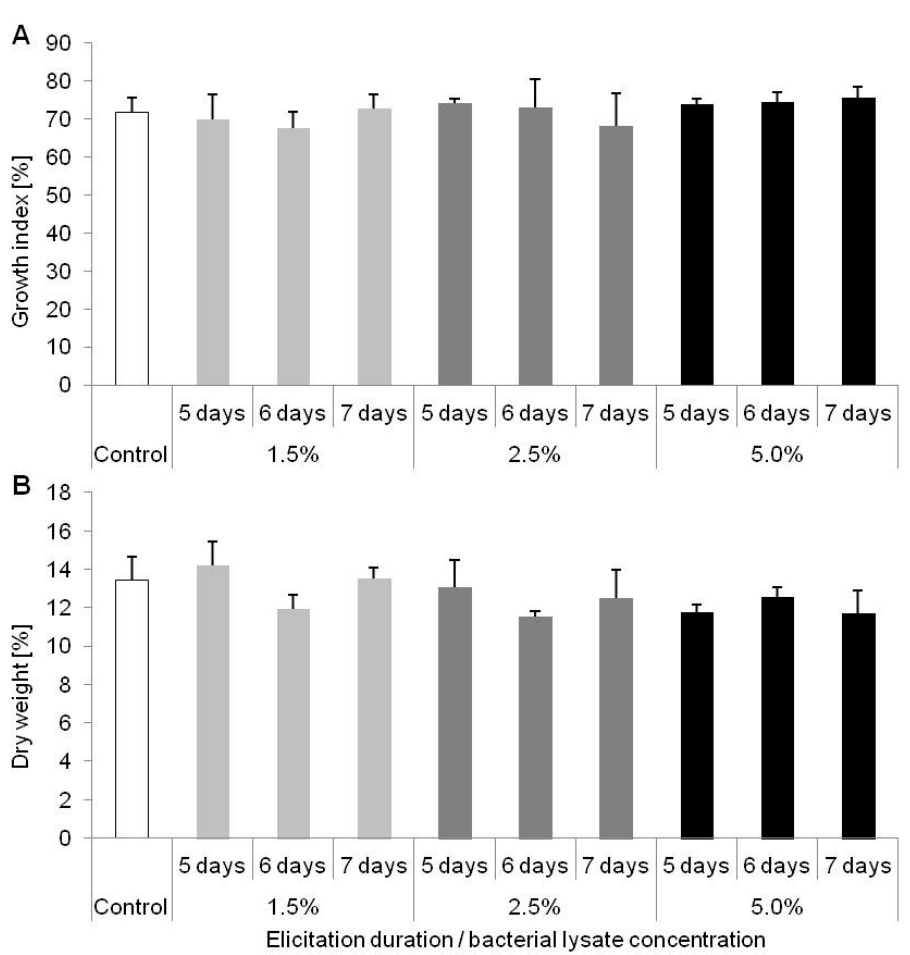
Figure 4. ( A ) Growth index (%) and ( B ) dry weight content (%) of Dionaea muscipula plants after 5, 6 and 7 days of elicitation with Cronobacter sakazakii lysate in different concentrations; no letters —no significant difference between means at p < 0.05; bar—standard deviation.